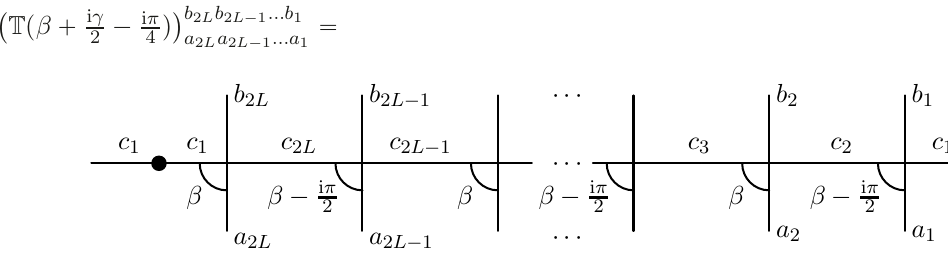
Figure 2. Graphical representation of the transfer matrix (5). The summation over the spin indices assigned to internal edges is